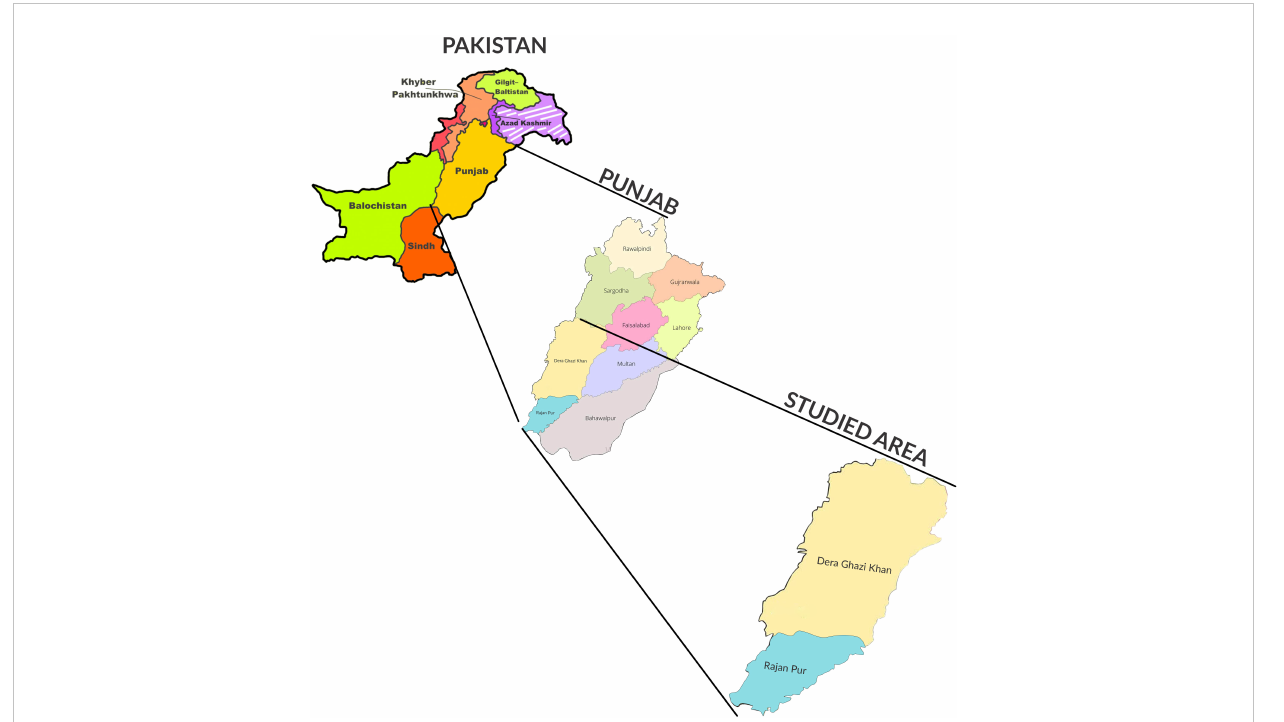
FIGURE 1 Map of Pakistan showing Punjab province and the selected study area of southern Punjab (speci fi cally, the Dera Ghazi Khan and Rajanpur